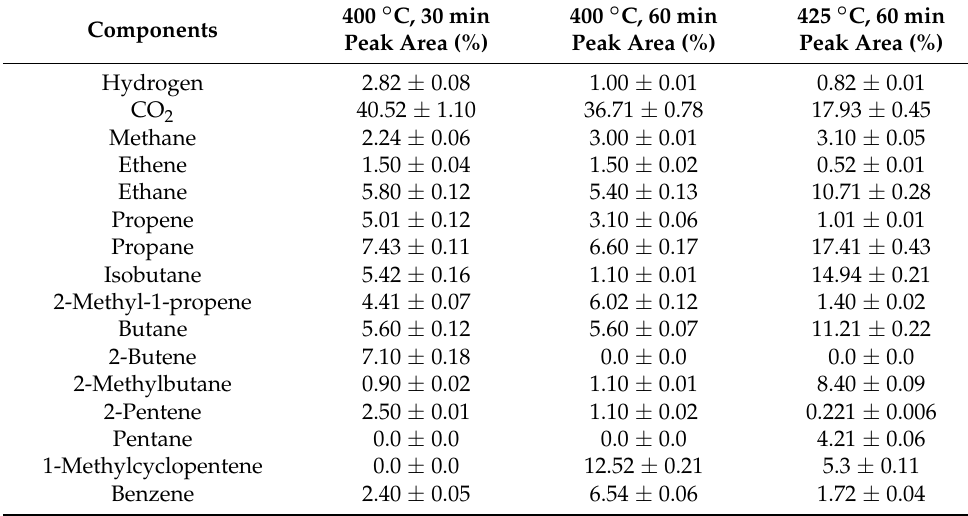
Table 1. Composition of the gas phase (peak area (%)) at different temperatures and reaction